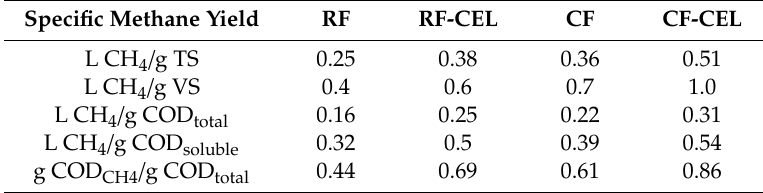
Table 6. Specific methane yield of